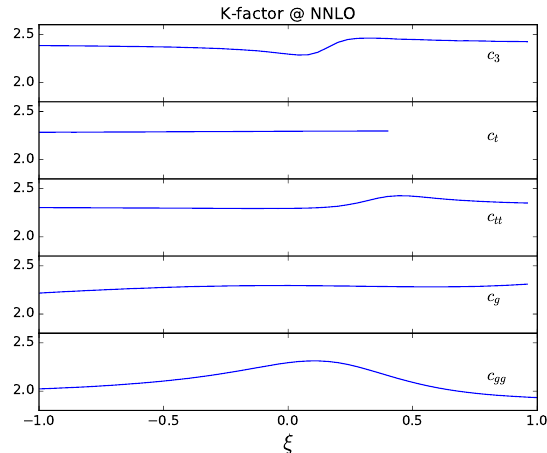
Figure 2 . K -factor for total production of Higgs boson pairs as a function of each anomalous coupling, whilst leaving the others set to their SM value. The SM corresponds to (cid:24) = 0 in all cases, and the parametrization in terms of (cid:24) is given by eqs.